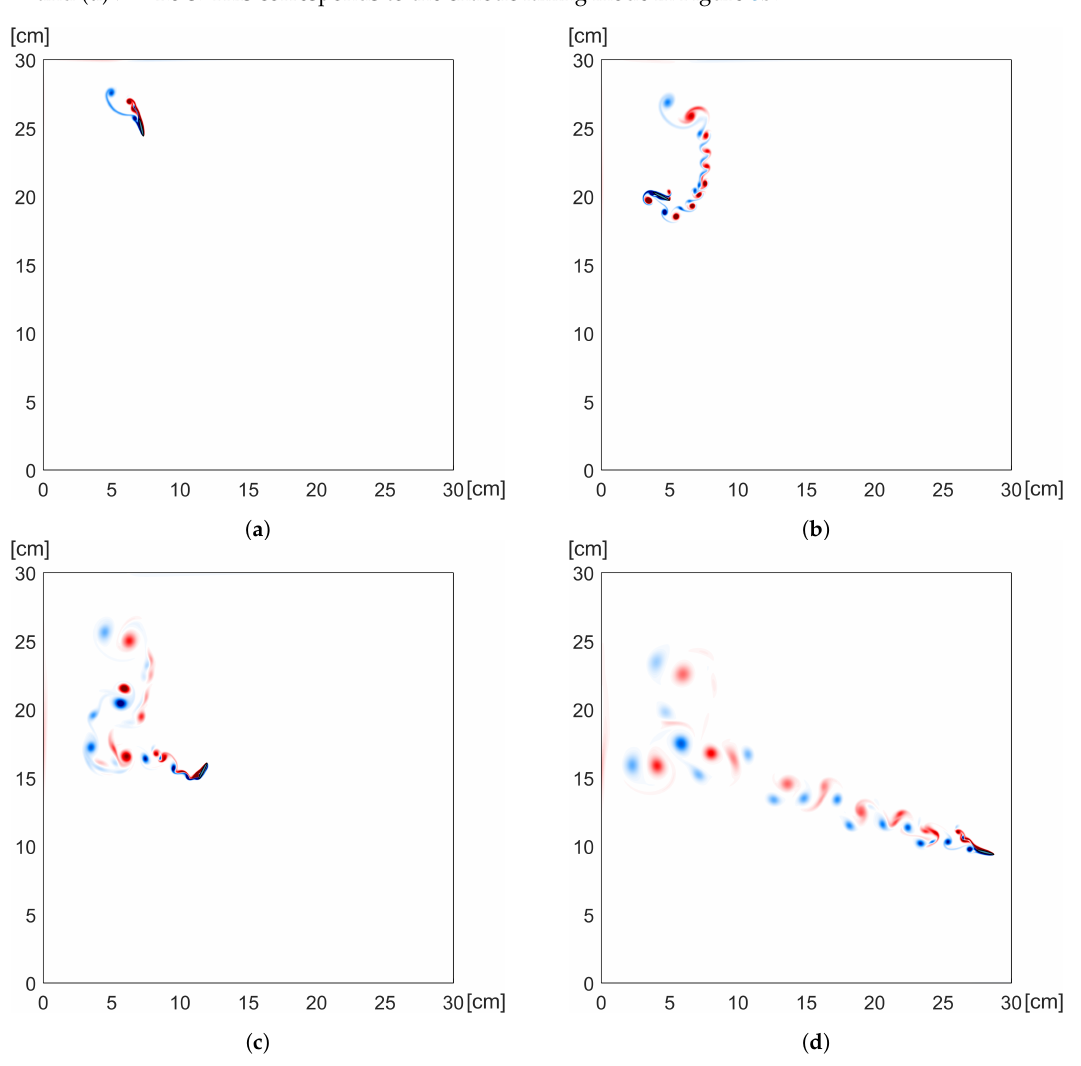
Figure 11. Wake structure in vorticity contours at time ( a ) t = 0.2 s, ( b ) t = 0.4 s, ( c ) t = 0.8 s, and ( d ) t = 1.6 s. This corresponds to the tumbling mode in Figure